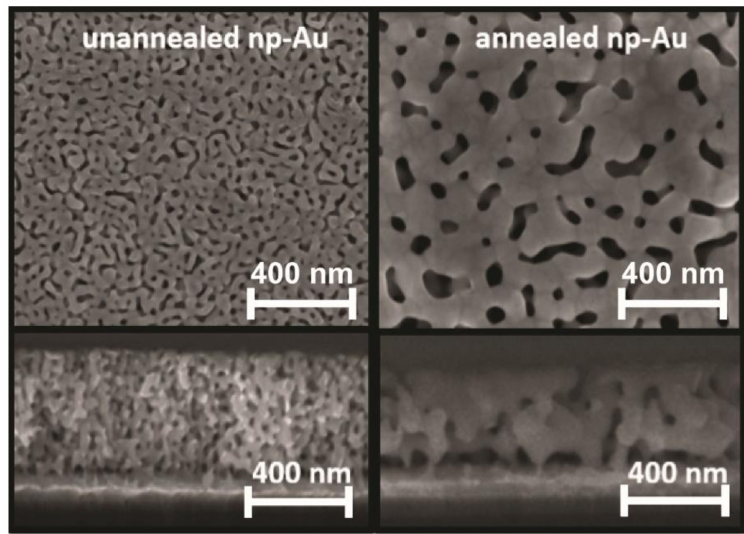
Figure 2. Scanning electron micrographs (SEM) of np-Au electrodes that were used for testing the influence of the electrode nanostructuring on the electro-grafting probe DNA density. Top and cross-sectional images are displayed in first and second row